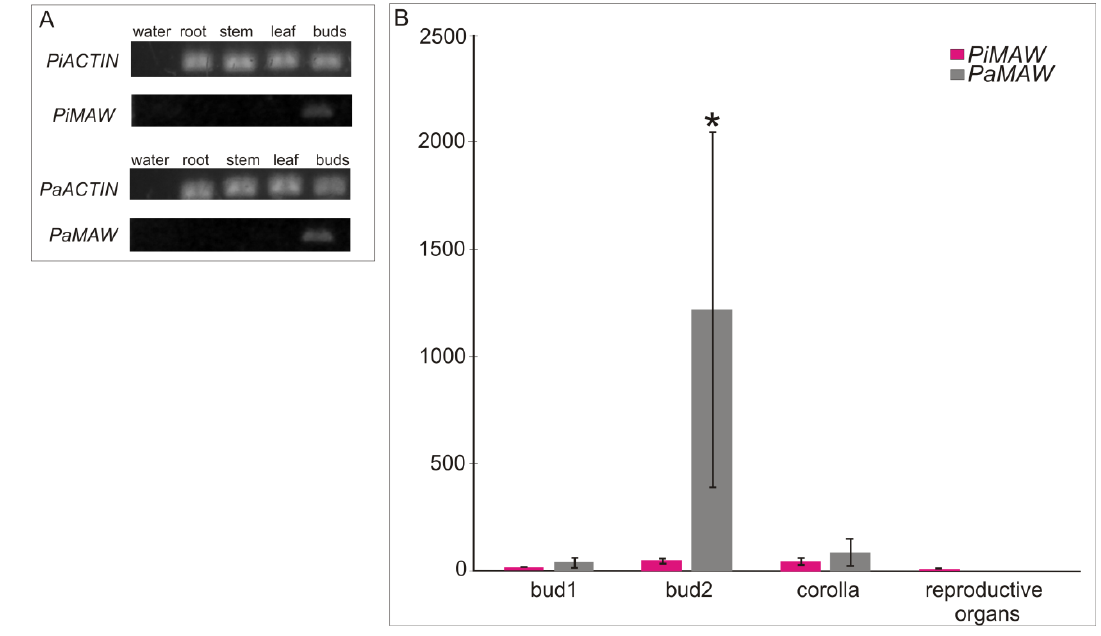
Figure 3. Gene expression analysis using RT-PCR and qRT-PCR. ( A ) Agarose gel electrophoresis of PCR amplification products of MAW transcripts from different floral organs of Petunia inflata and Petunia axillaris : mature root, stem and leaves, and floral buds; ( B ) Relative expression analysis of MAW transcripts present in P. inflata and P. axillaris by q-PCR. P. axillaris reproductive organs were used in calibrating the relative expression analysis among tissue types in both species. Relative expression was plotted using the ACTIN gene as a normalizer. Error bars represent the SEM of four biological and three technical repeats. PiMAW is P. inflata MAW gene expression; PaMAW is P. axillaris MAW gene expression; PaACTIN is P. axillaris and PiACTIN is P. inflata ACTIN2 gene expression. Bud1: buds < 5 mm in length and Bud2: buds ≥ 5 mm in length. * significantly different means ( p <